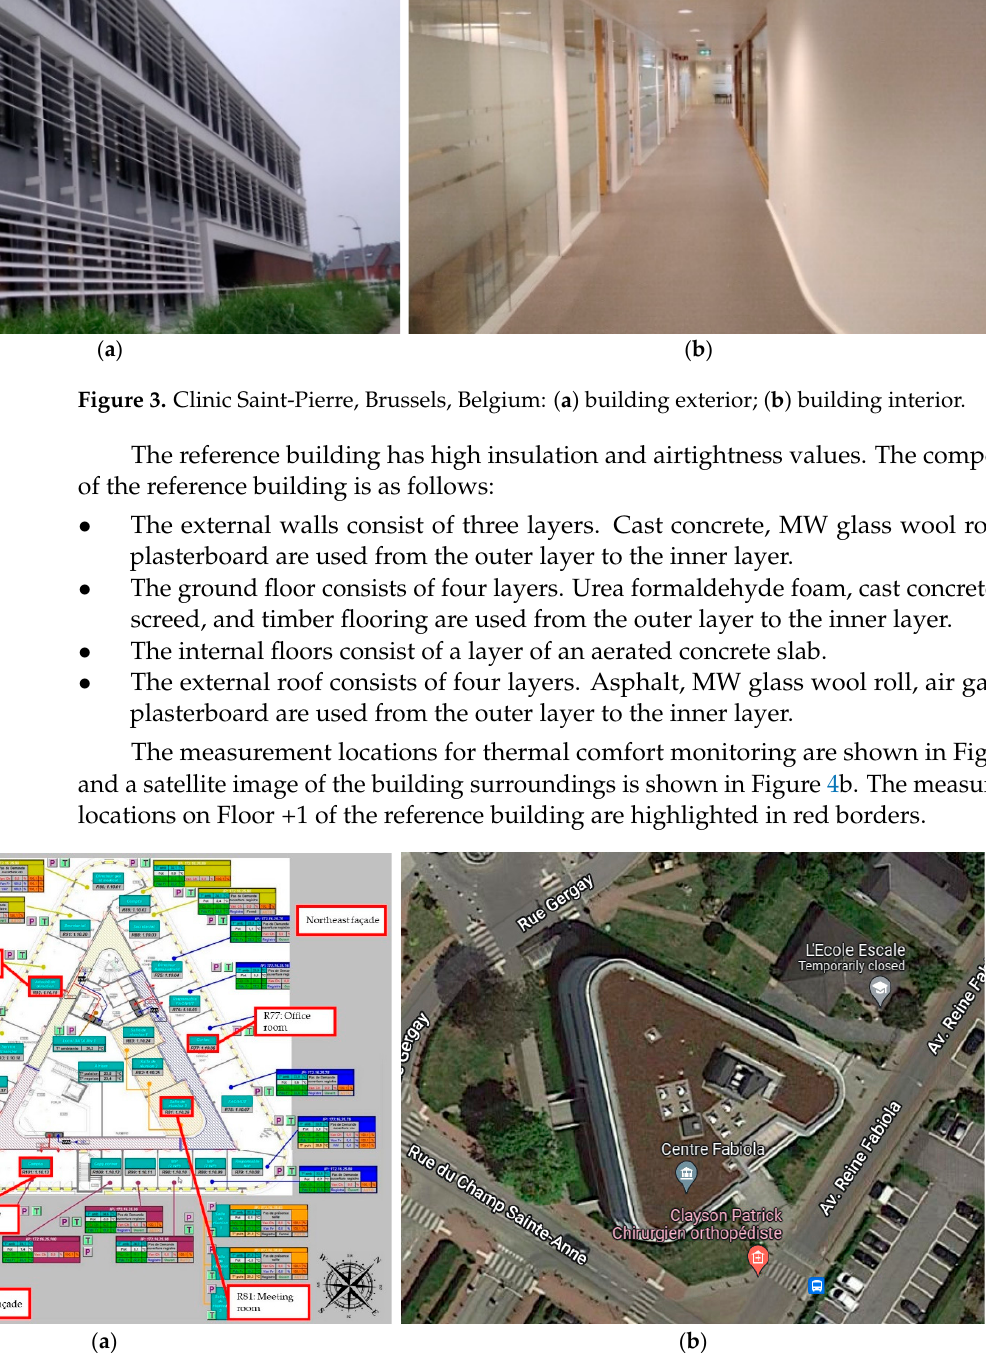
( b ) Figure 5. Reference building measurement locations used for the energy use evaluation: ( a ) cooling energy (electricity) use (kWh); ( b ) heating energy (natural gas) use (kWh). 2.3. Performance Evaluation Performance evaluation gives a crucial and quantified analysis of the target parame ‐ ters within the scope of the case study. The list of parameters is given below. 2.3.1. Time ‐ Integrated Thermal Discomfort Thermal comfort is defined as “the condition of mind that expresses satisfaction with the thermal environment and is assessed by subjective evaluation” according to ASHRAE Standard 55 [25]. Thermal comfort is one of the most important factors that affect occupant productivity, health, and well ‐ being [26]. This is significant since, especially in developed nations, people spend up to 90% of their time indoors [27]. In this study, the thermal discomfort indicators used are asymmetric indices that in ‐ clude overheating and overcooling ‐ specific [28]. The overheating and overcooling dis ‐ comfort was estimated using 𝐼𝑂ℎ𝐷 [29,30] and 𝐼𝑂𝑐𝐷 [30]. The 𝐼𝑂ℎ𝐷 and 𝐼𝑂𝑐𝐷 are mul ‐ tizonal indices that add together the heating and cooling degree hours over the total